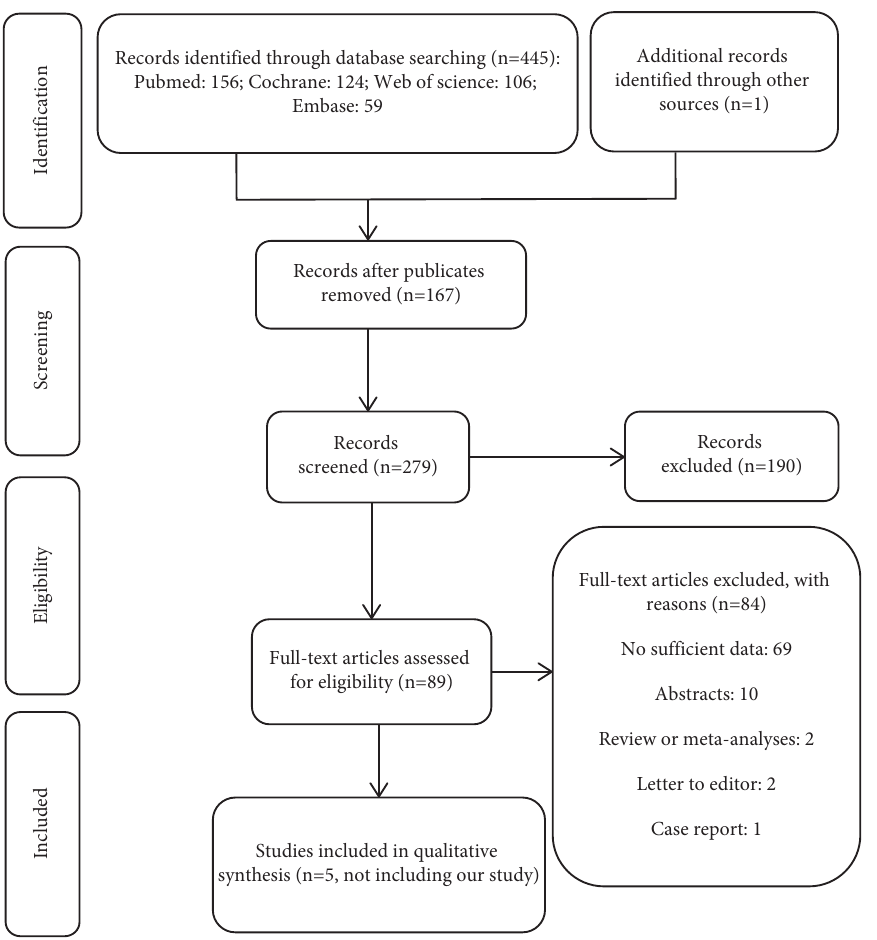
Figure 1: Flowchart of the literature search and study selection process. Table 2: General characteristics of the included